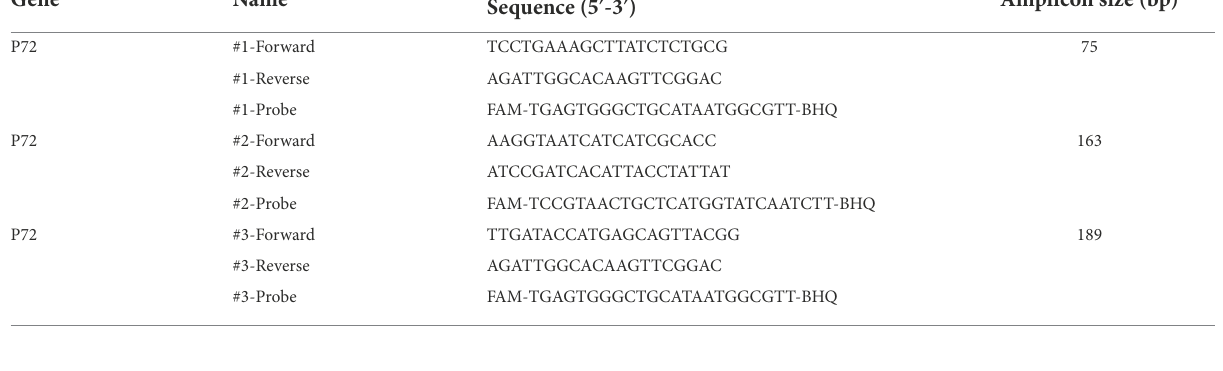
TABLE 2 Primers and probes used in the PMAxx-qPCR assay for detecting the P72 gene of ASFV.